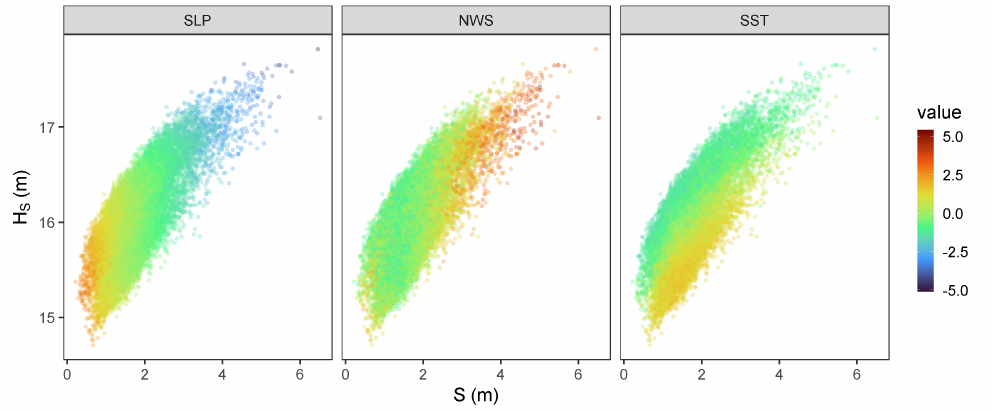
Figure 10. Normalized covariate values for the highest-density points of the 0.99 quantile level curve for each day of the observation period. The covariate values are displayed for the coordinates selected for the variables’ interaction S × H S only (i.e., the middle columns of Figures 3 and 4), which explains why the levels attained for some covariate values seem